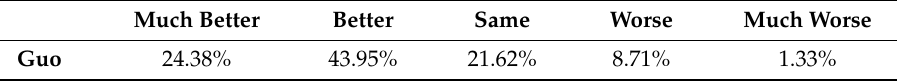
Table 8. Quantitative comparisons between Guo and